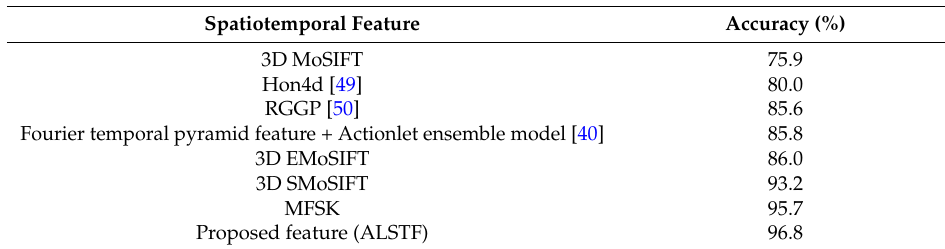
Table 8. The comparison of different spatiotemporal features on the MSR DailyActivity3D dataset in leave-one-out cross validation setting.